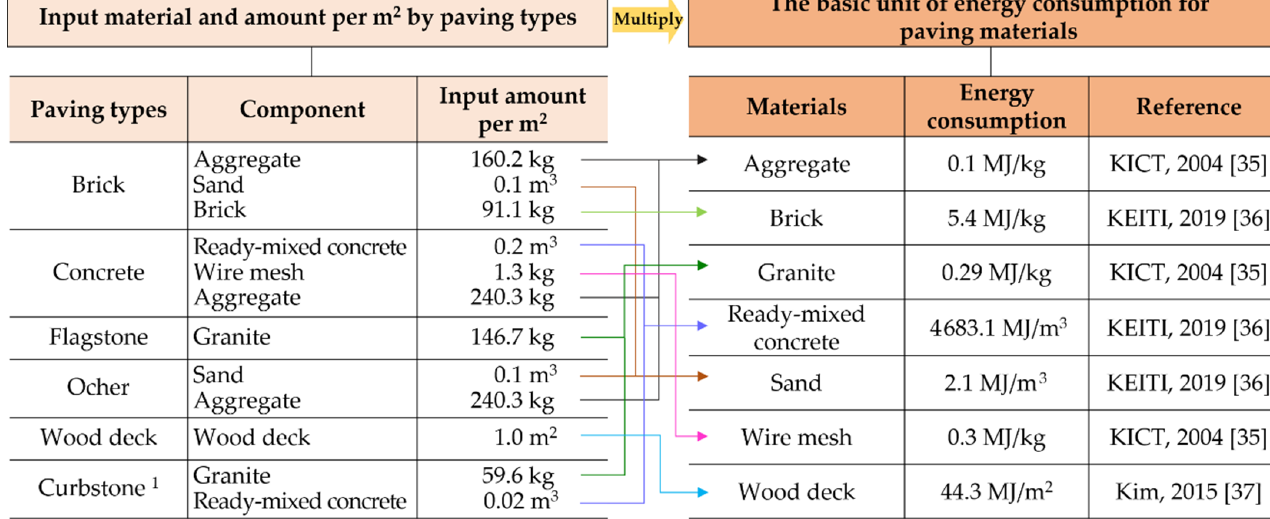
Figure 4. The calculation process of energy consumption per square meter by paving materials. 1 The unit of curbstone is piece instead of square meter [35–37].